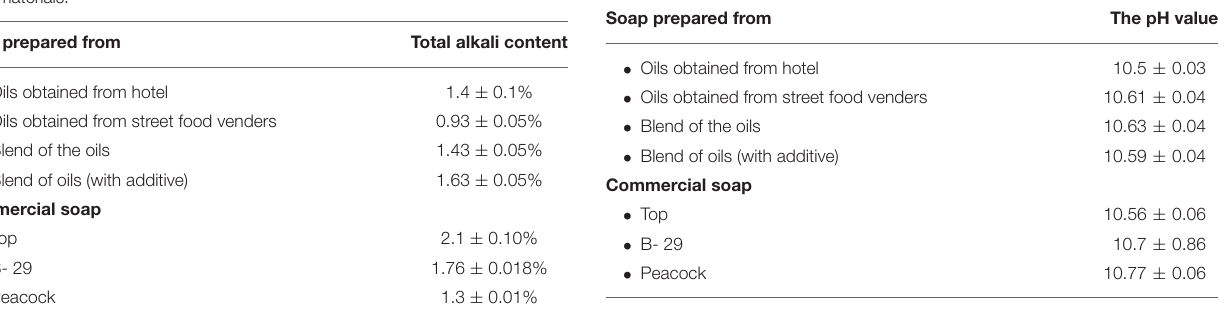
TABLE 3 | The values of total alkali contents of the prepared and commercial soap materials.